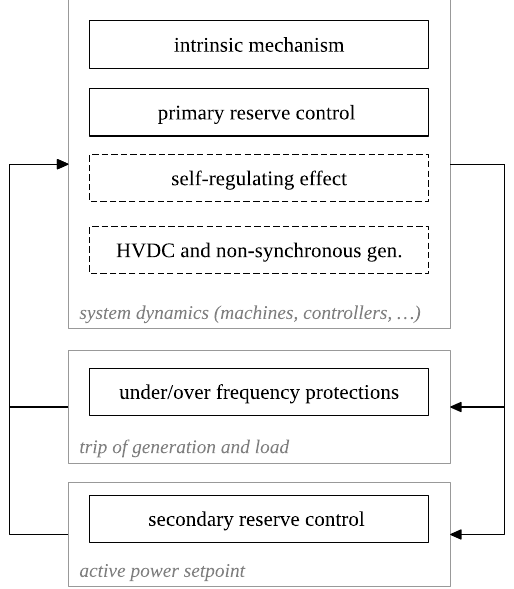
Figure 6. Flowchart of the extended LFC